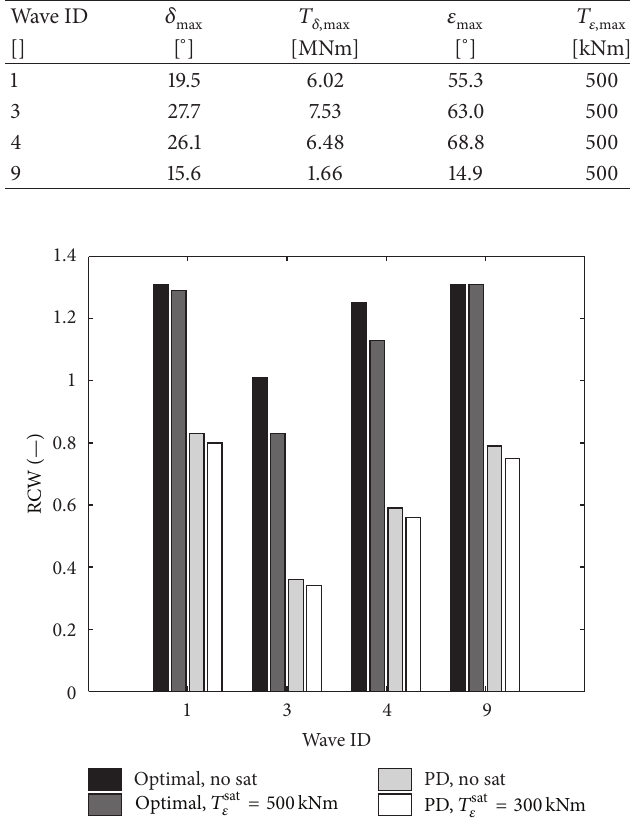
Figure 9: ISWEC RCW comparison between optimal and linear reactive controller with and without torque